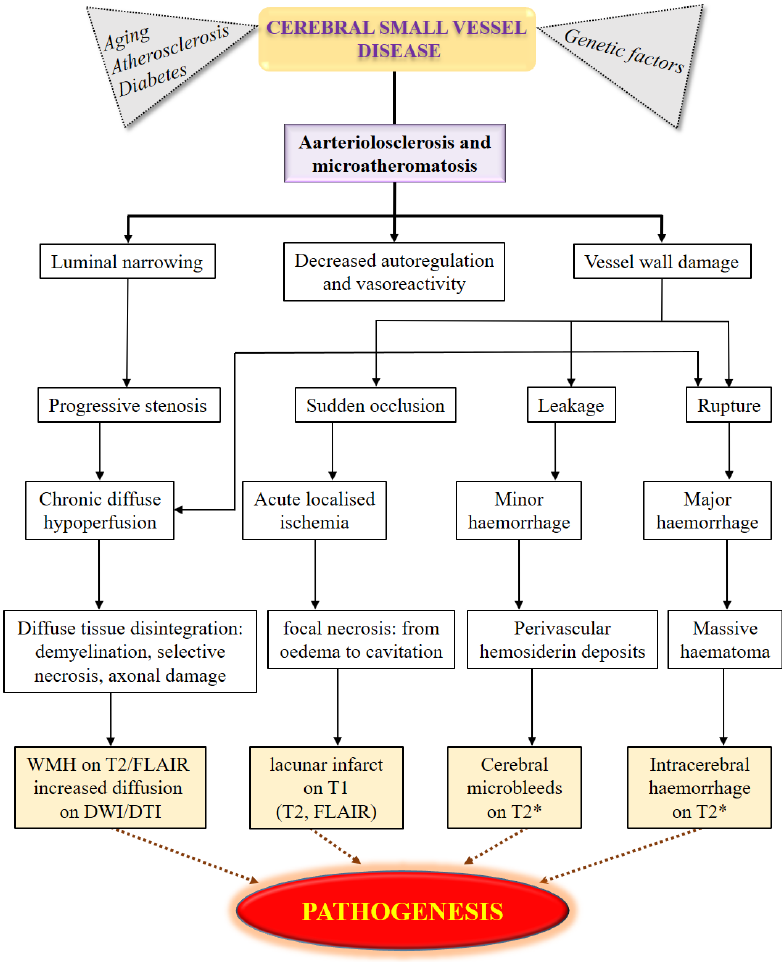
Figure 1. Pathogenesis of cerebral SVD manifestations in development and its progression.